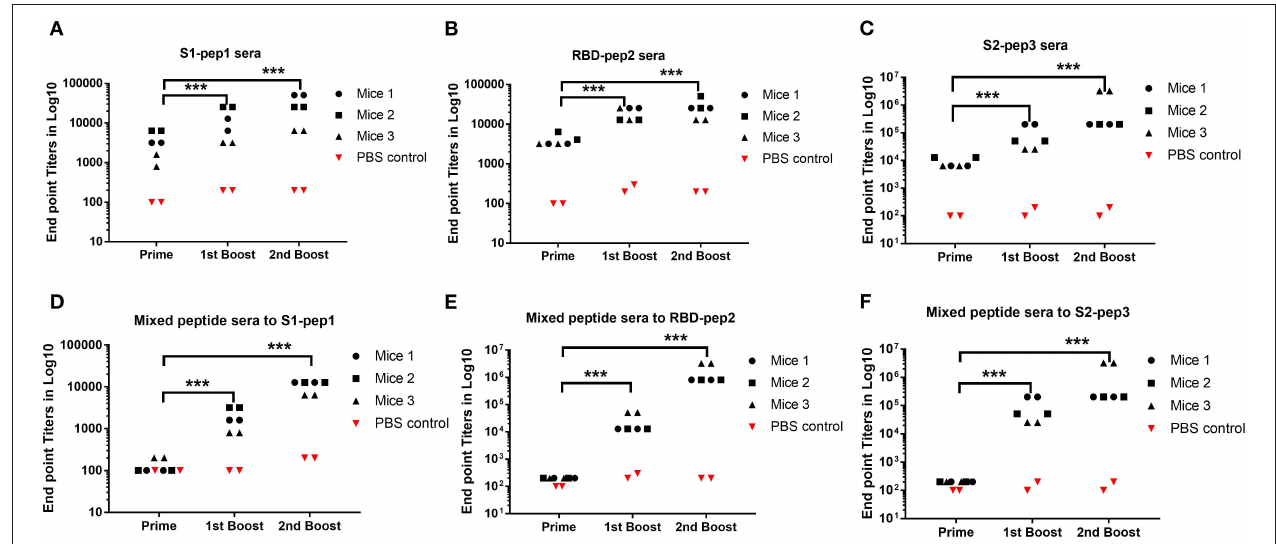
FIGURE 2 | Humoral responses to peptide immunization. Serum whole IgG responses as measured by ELISA and expressed as endpoint antibody titer (Mice no. 1–12). (A) Binding antibody titers of immunized Group 1 to S1-pep1. (B) Binding antibody titers of immunized Group 2 to RBD-pep2. (C) Binding antibody titers of immunized Group 3 to S2-pep 3, sera from priming, sera from the first boost, and sera from the second boost. (D) Binding antibody titers from the first boost of immunized Group 4 mixed peptide sera to S1-pep1. (E) Binding antibody titers from the first boost of immunized Group 4 mixed peptide sera to RBD-pep2. (F) Binding antibody titers from immunized Group 4 to S2-pep3. The plates were coated with respective peptides at a concentration of 2 µ g/ml. Values plotted are the mean endpoint titers in duplicate. Each dot represents a single mean value of three repeated experiments. Statistical significance was determined using the one-way ANOVA test ( p < 0.05), where *** p < 0.001 (one-way ANOVA).